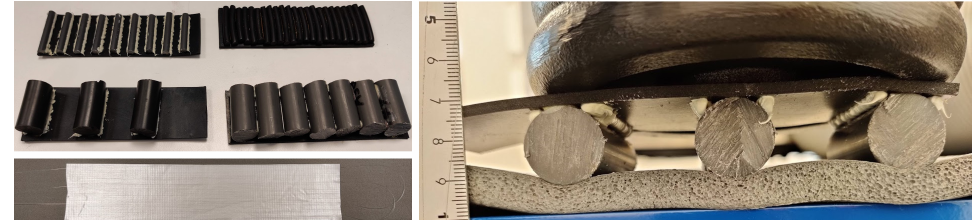
Figure 4. The experimental investigation of the sensor design. Top left, examples of the impactor samples created, showing both soft rubber and hard PVC plastic impactor materials, and gapped and adjacent designs. The white substance around the gapped impactors is supporting adhesive. Bottom left, the two different fibres taped to the foam mat. Top right, an example of the bending of the mat upper surface, and therefore also the taped fibres, under an applied weight load on top of an impactor sample.